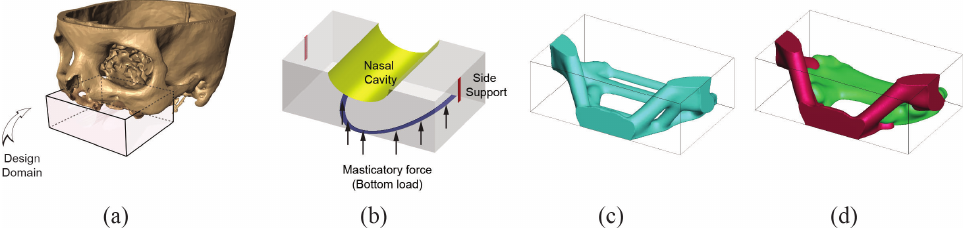
Figure 7. Case 2—Scenario 1: mastication loading is purely vertical. ( a ) Design domain extraction from patient CT scan, ( b ) boundary condition used in the analysis, ( c ) bone replacement shape using single material topology optimization, ( d ) bone replacement shape with 2 material topology opti- mization.